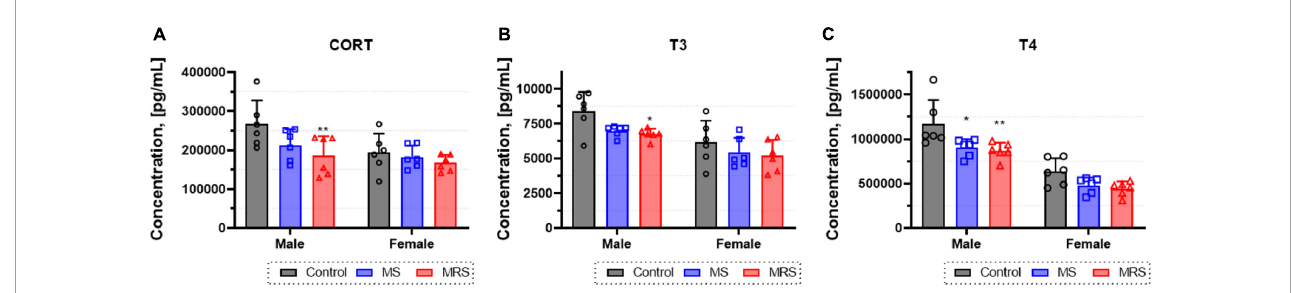
FIGURE4 Concentration of corticosterone (A) , T3 (B) , and T4 (C) levels form blood serum. Data are presented as means ± SD ( n = 6). Statistical significance was defined as a p -value less than 0.05 (* p < 0.05, ** p <